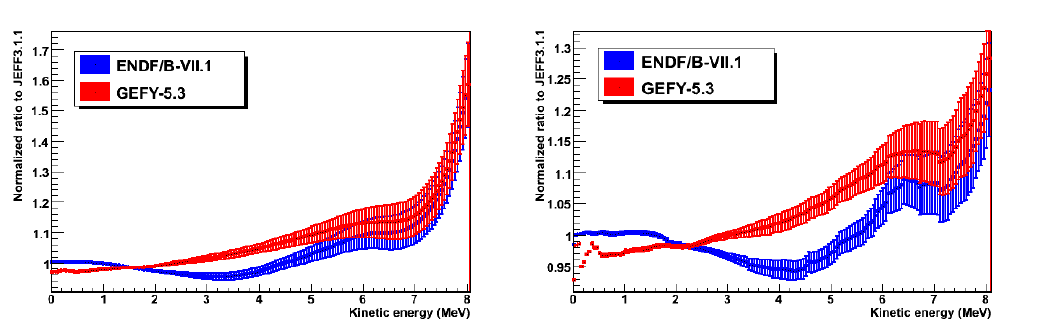
Figure 4. Normalized ratio of the calculated energy spectra for 235 U using cumulative fission yields from ENDF / B-VII.1 and GEFY-5.3 to the calculated spectra using JEFF3.1.1 for electrons (left) and anti-neutrinos (right). The uncertainties are propagated nuclear data bases